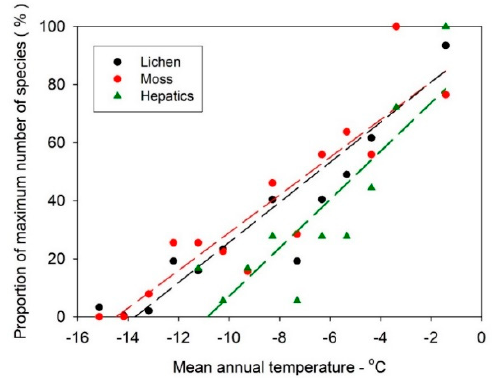
Figure 3. Number of species of lichens, mosses, and hepatics as a percentage of their maximum number (usually close to warmest place) plotted against mean annual temperature. The fitted lines are linear regressions all P < 0.0001, r 2 are 0.83, 0.84, and 0.75, respectively. Data for Antarctic Peninsula and Ross Sea.